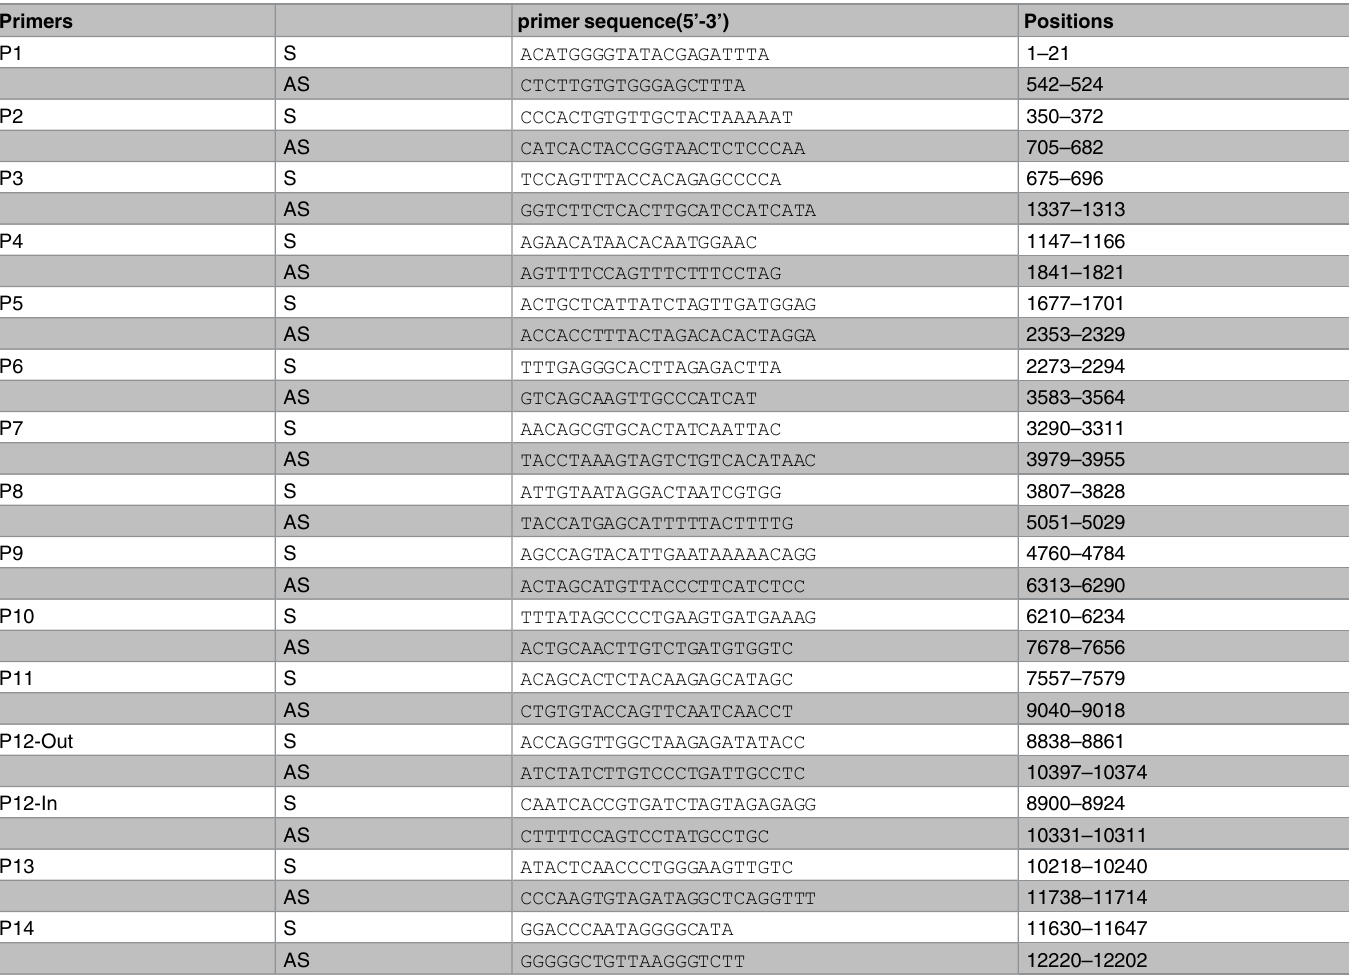
Table 2. Primers used for amplification of the complete genome